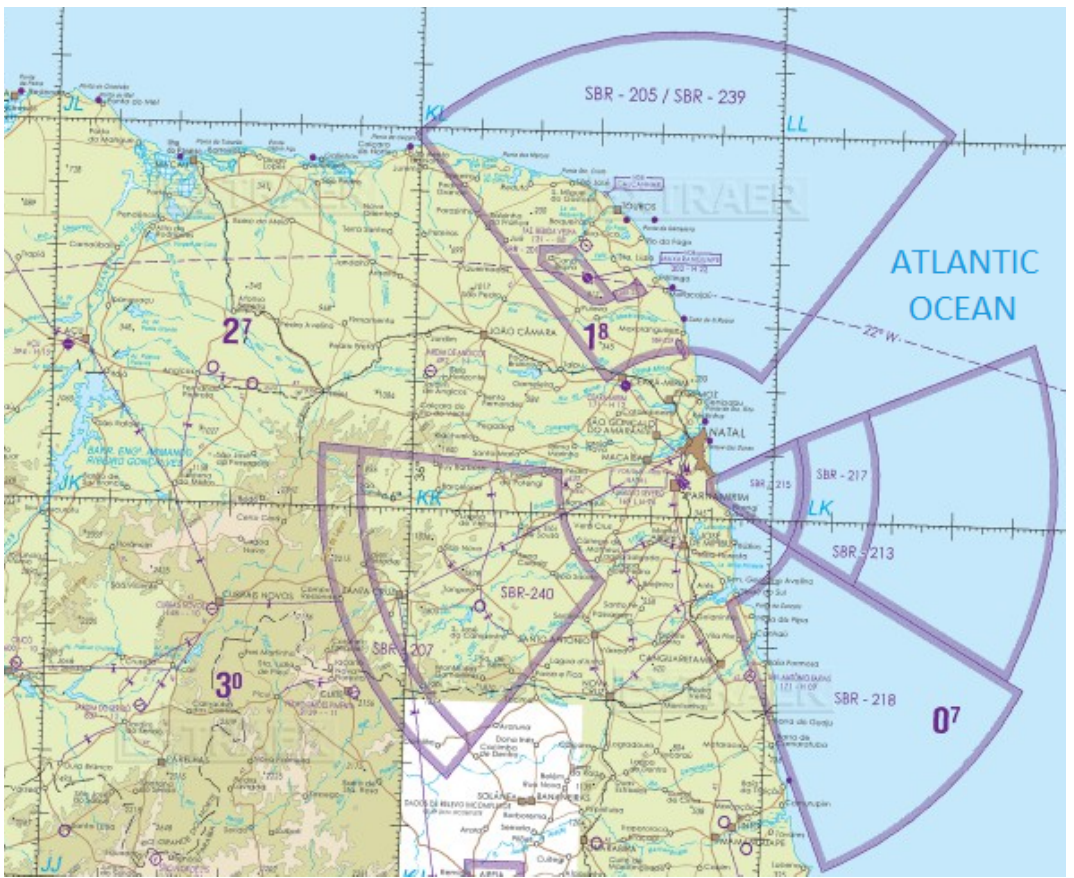
Figure 1. Impact area of a rocket launched from CLBI (Barreira do Inferno Launch